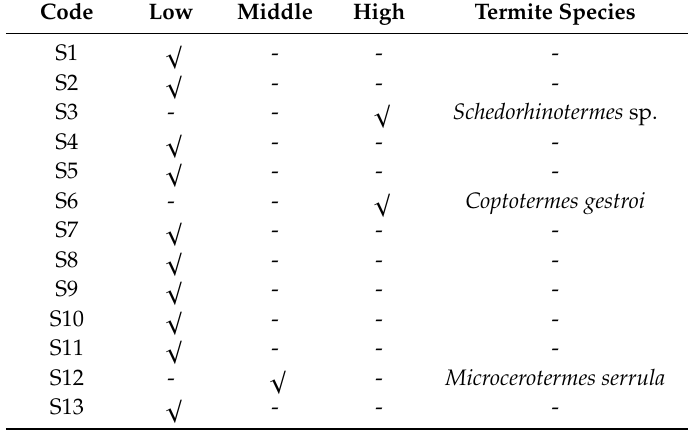
Table 4. Risk class of termite attack in Makassar city.